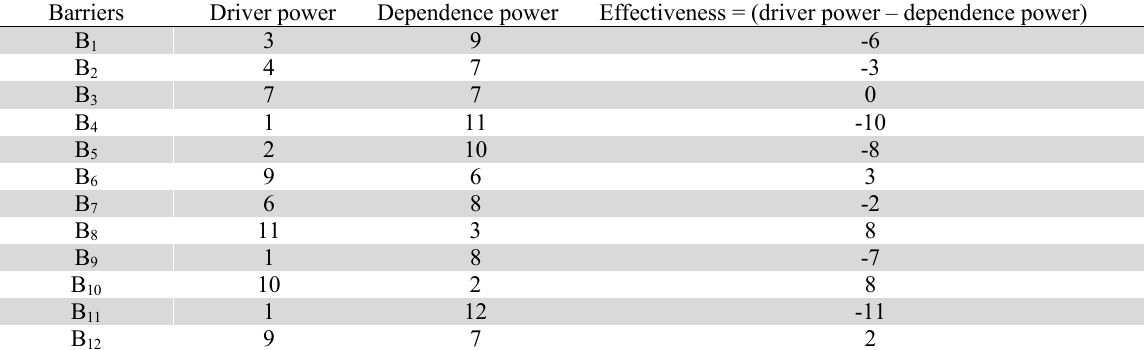
Difference in driver power and dependency